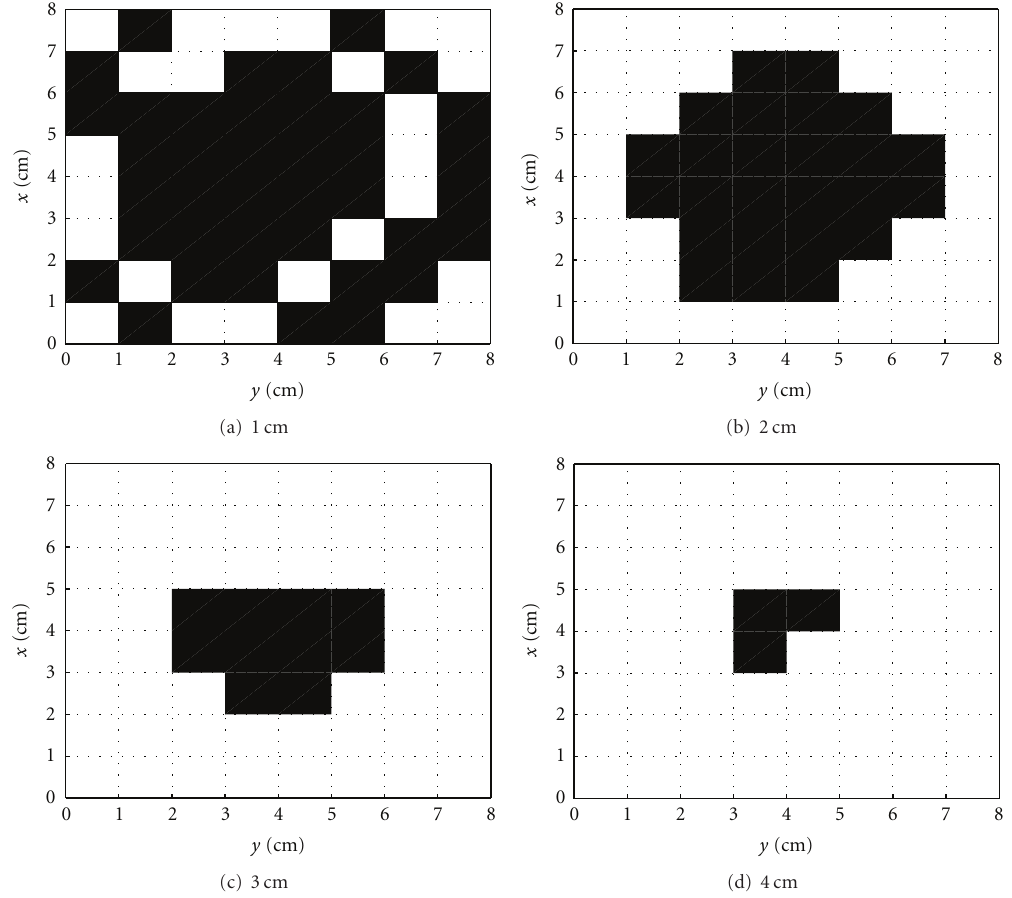
Figure 6: Interrogation range of antenna at di ff erent distances which are 1cm, 2 cm, 3cm, and 4 cm. Black grid marked the intersection which could be read when tag is put on, and white grid marked the